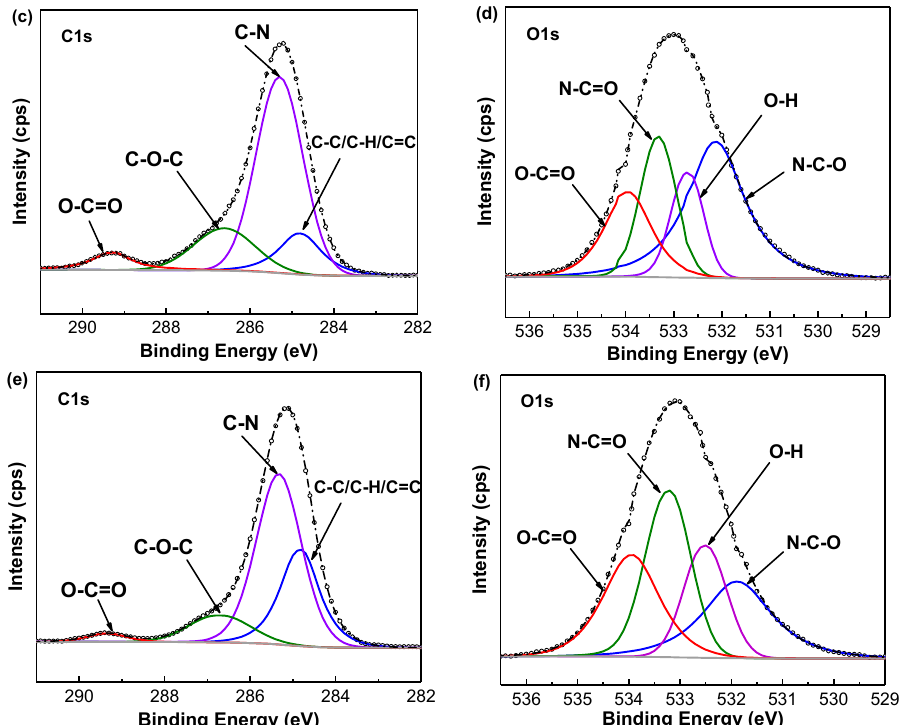
Figure 23. Split peak fitting of the XPS spectra of C1s and O1s: ( a , b ) epoxy coating exposed for 7 years; ( b , c ) epoxy coating exposed for 12 years; ( e , f ) epoxy coating exposed for 20 years.